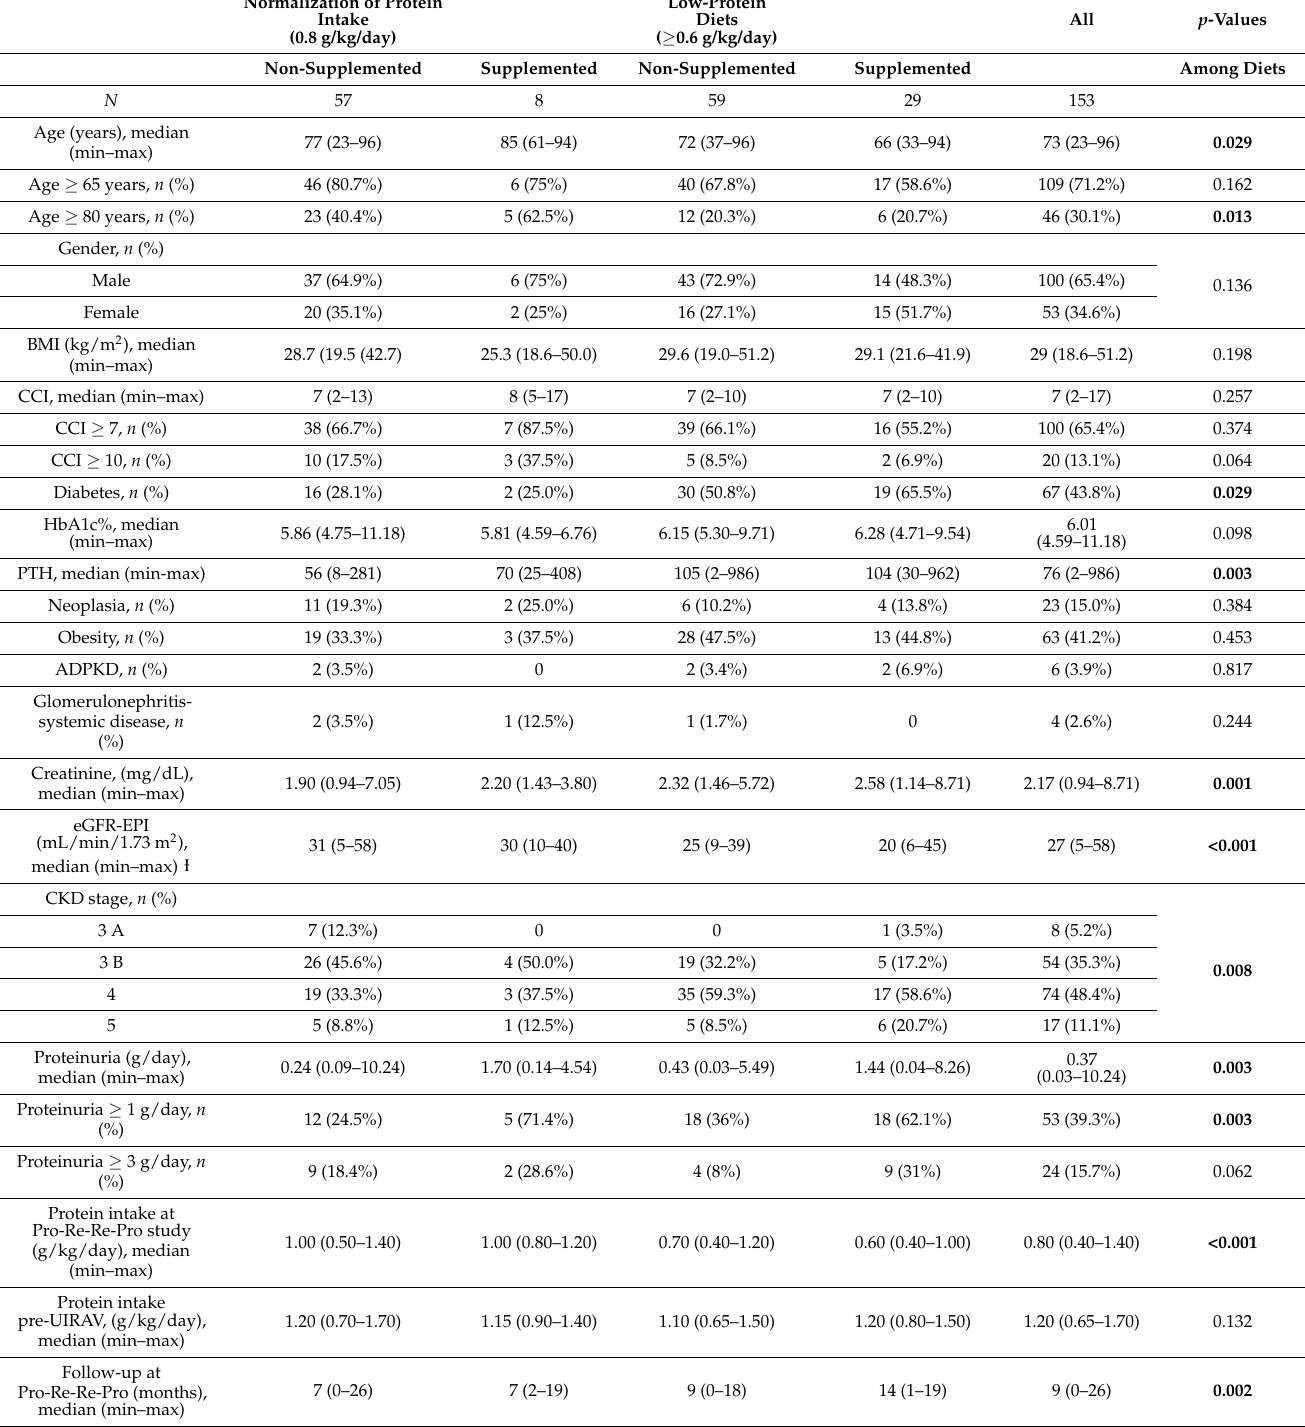
Table 2. Diet distribution in the UIRAV